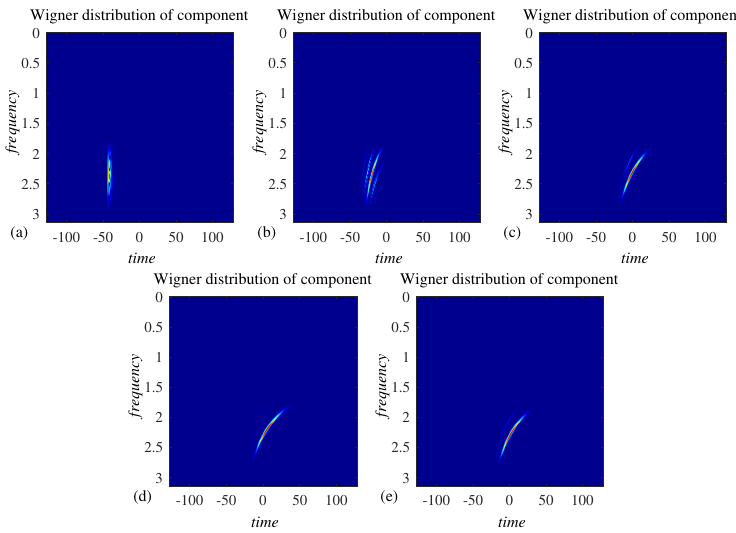
Figure 17. ( a – e ) Extracted modes of the signal received from the dispersive acoustic environment. The decomposition is performed using the presented multivariate